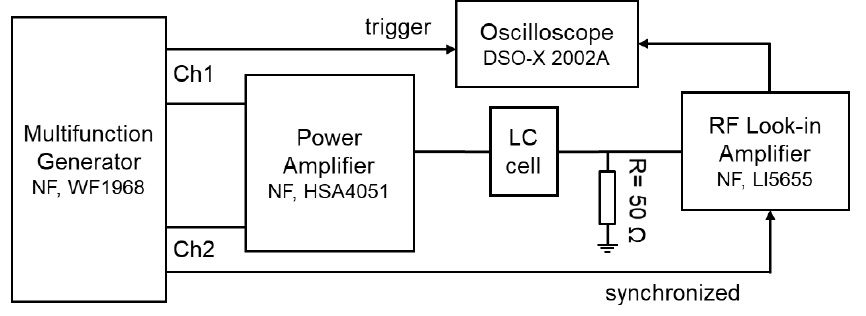
Figure 6. Block diagram of the permittivity measurement system.